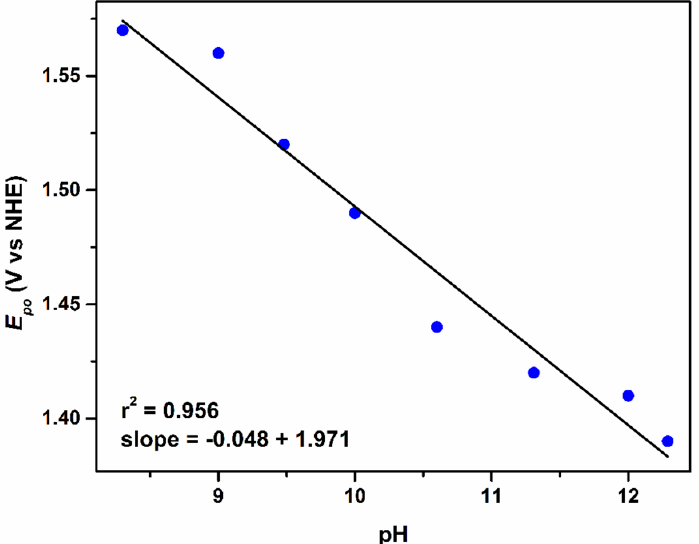
Figure 12. Variation of the catalytic water oxidation potential with pH. The voltammograms are recorded in solutions containing 1.0 mM Na 3 [Ru 2 ( µ- CO 3 ) 4 ] in 0.10 M NaHCO 3 at various pHs un- recorded in solutions containing 1.0 mM Na 3 [Ru 2 ( µ - CO 3 ) 4 ] in 0.10 M NaHCO 3 at various pHs under der N 2 atmosphere, scan rate 50 mV·s − 1 . The onset potential is taken at a current of 400 µA. N 2 atmosphere, scan rate 50 mV · s − 1 . The onset potential is taken at a current of 400 µ A.